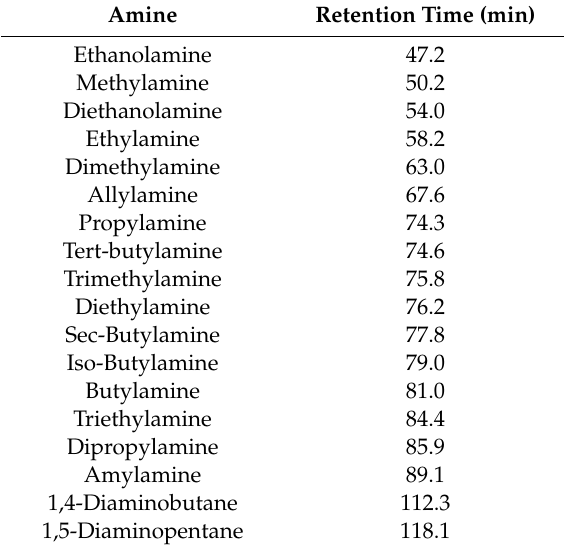
Table 1. List of the amines along with their retention times that can be identified using the Thermo Scientific Dionex IonPac CS-19 (4 × 250 mm) column following the method described in the main text.